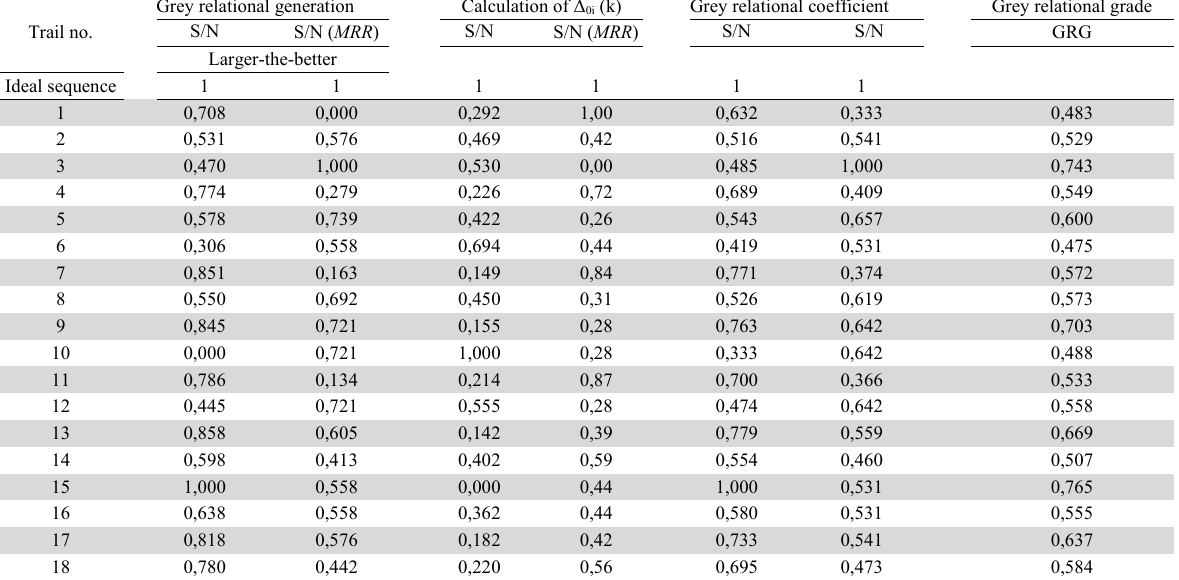
Results of grey relational generation, calculation of Δ 0i (k), grey relational coefficient and grey relational grade Trail